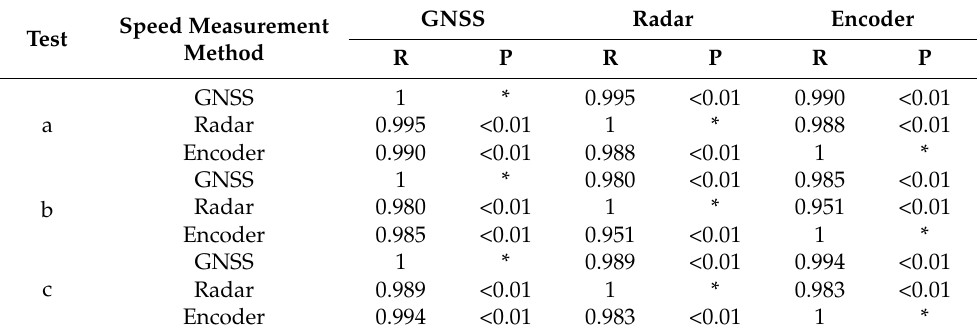
Table 5. Pearson correlation analysis results of the real-time seeding spacing monitoring values of the three speed measurement methods. Speed Test